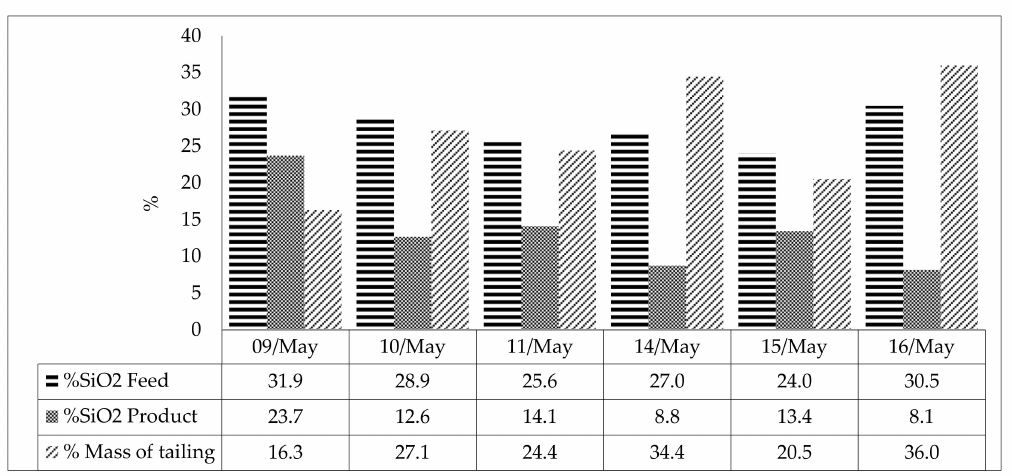
Figure 12. SiO 2 content in the flotation feed and product; percentage of mass in the